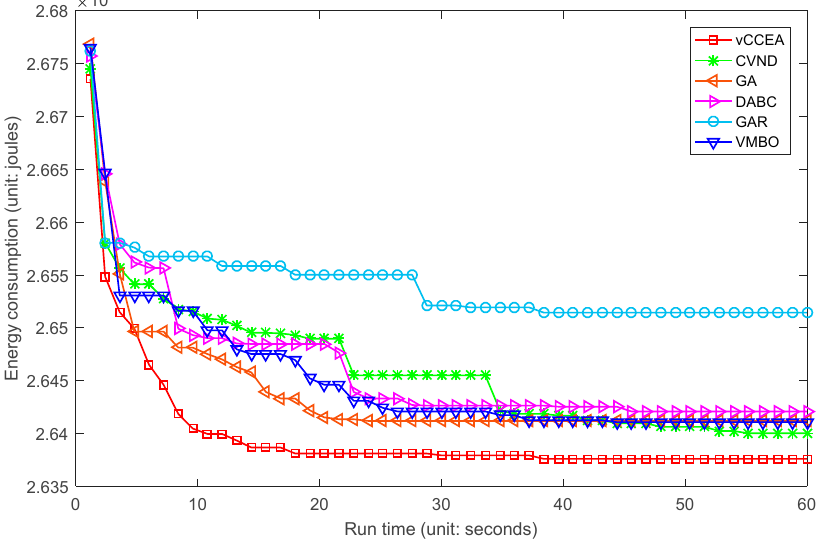
Figure 11. The convergence curve for instances of 80 × 10.